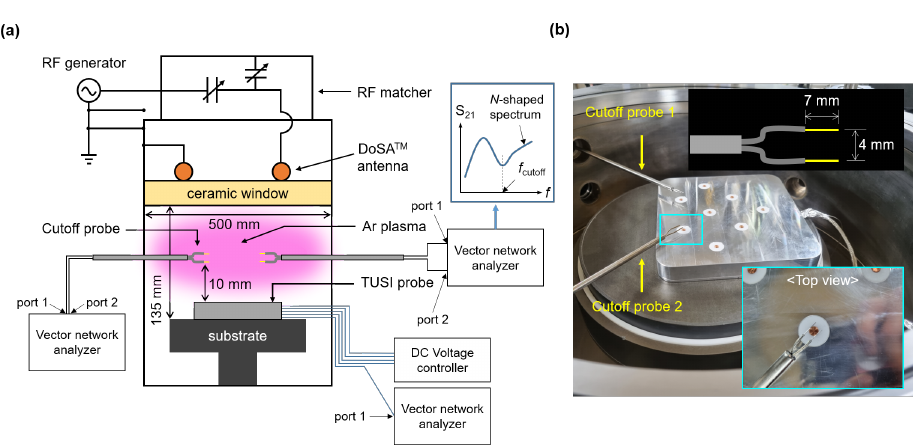
Figure 3. ( a ) Schematic diagram and ( b ) photograph of the experiment setup for the demonstration of the TUSI probe with the cutoff